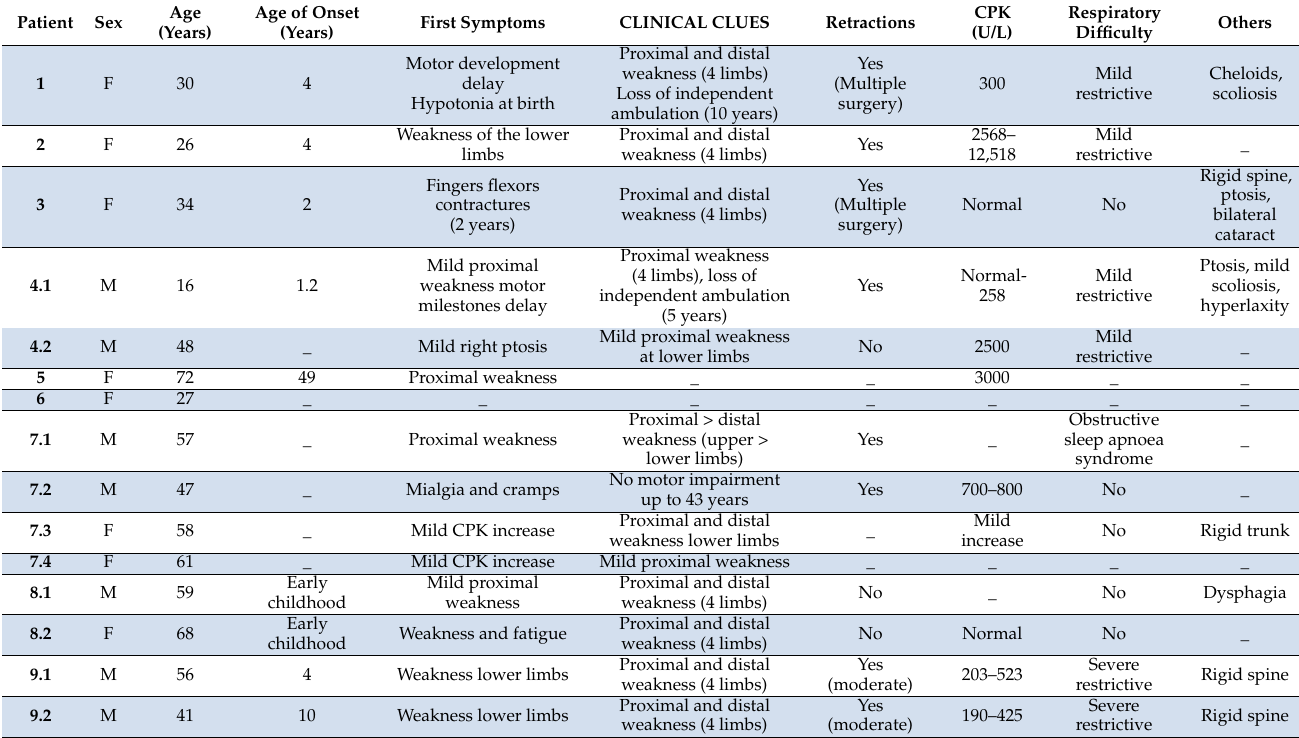
Table 1. Demographic and clinical